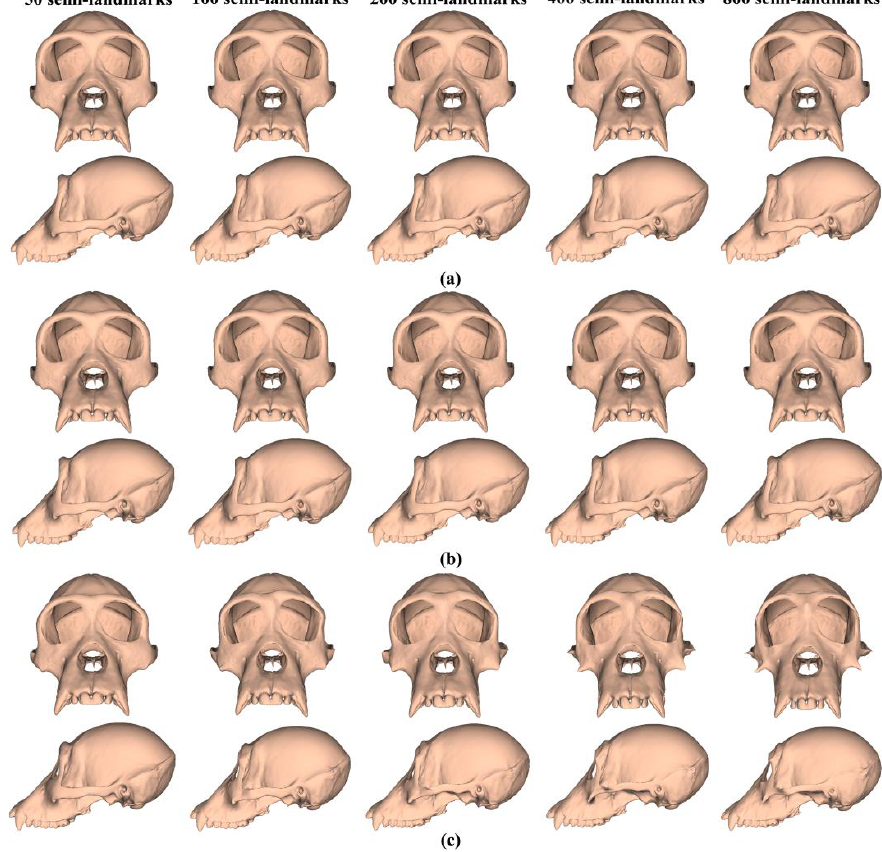
Figure 8. Surface meshes of the estimated mean ape cranium generated using different semiland- marking approaches after re-semilandmarking and re-warping. ( a ) Sliding TPS. ( b ) TPS&NICP. ( c )